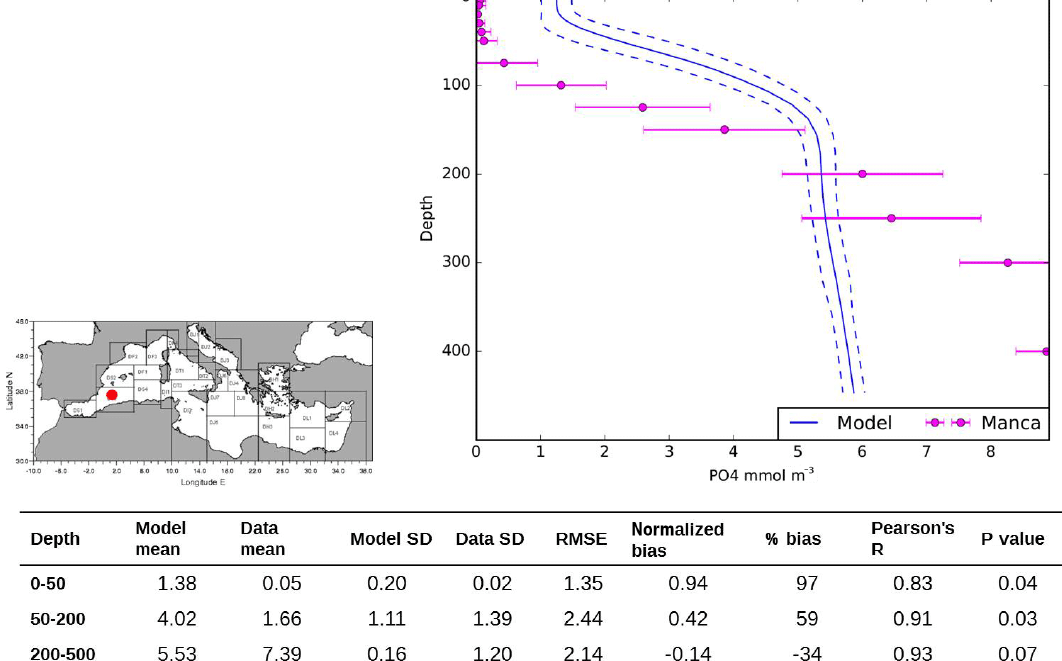
Figure A6. Annually averaged NO 3 vertical profile in the Algerian sub-basin (see map and Manca et al., 2004) and statistical indicators over different depths. Model values are shown with the blue line (2005 average, Ntot simulation from Richon et al., 2017) and measured values from Manca et al. (2004) are in pink. Horizontal bars and dashed lines indicate the spatial SD of observations and model results